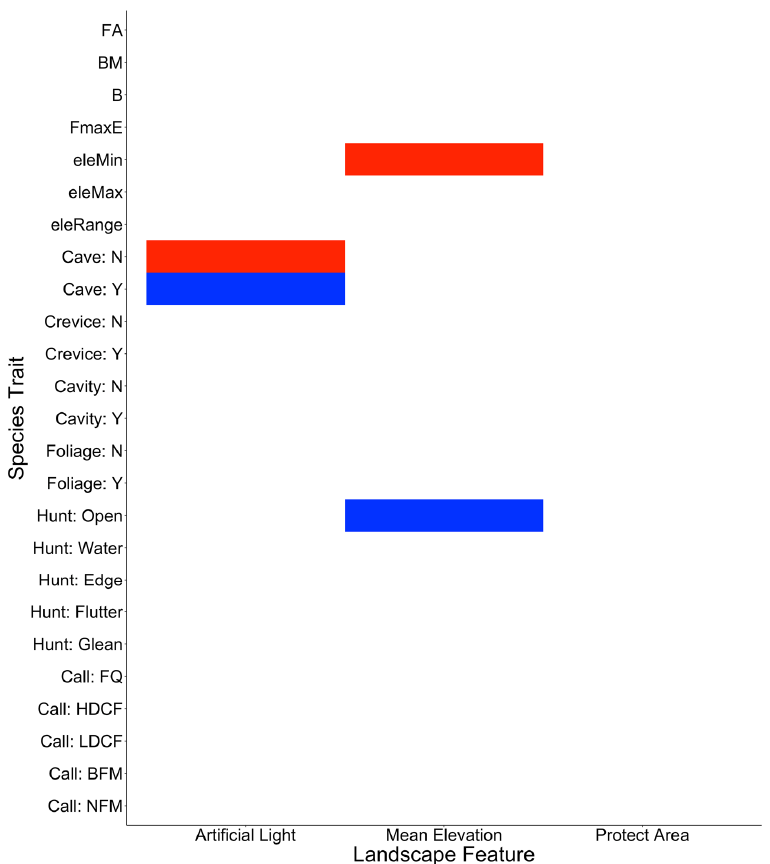
Figure 5. Results of the fourth corner analysis for bat roadkill. Colorful rectangles represent significant trait–landscape feature associations. Red rectangles indicate positive correlations, whereas blue rectangles indicate negative correlations. Trait abbreviations: FA—forearm length, BM—body mass, B—wingspan, FmaxE—call frequency of maximum energy, eleMin—minimum elevation, eleMax—maximum elevation, eleRange—elevational range; for roost use, Y and N stand for use and not use of the roost type prior to the semi-comma, e.g., Cave: Y denotes use of cave roost; for